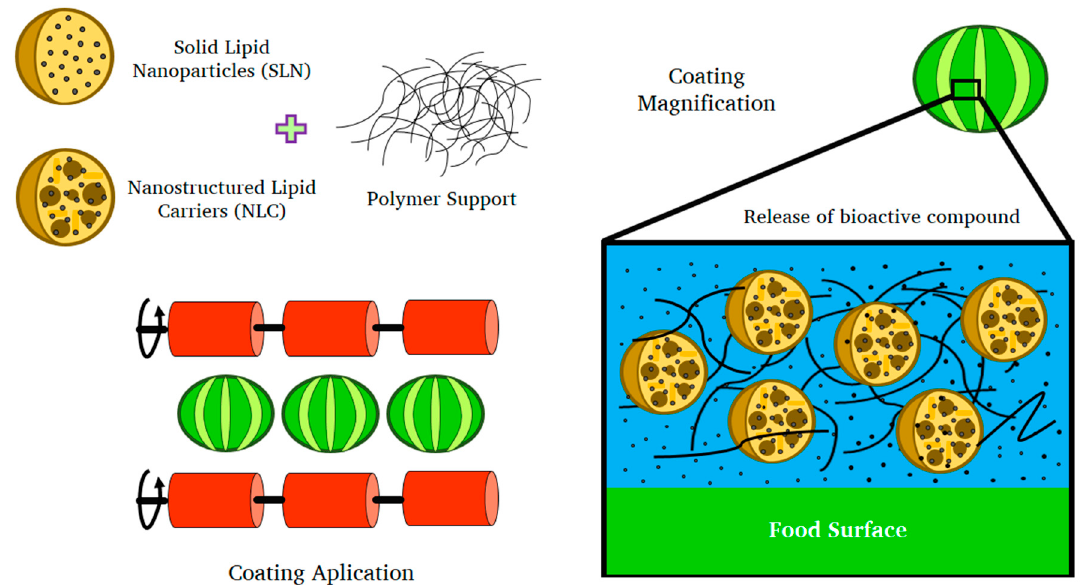
Figure 3. Solid lipid nanoparticles and nanostructured lipid carrier in edible coatings.